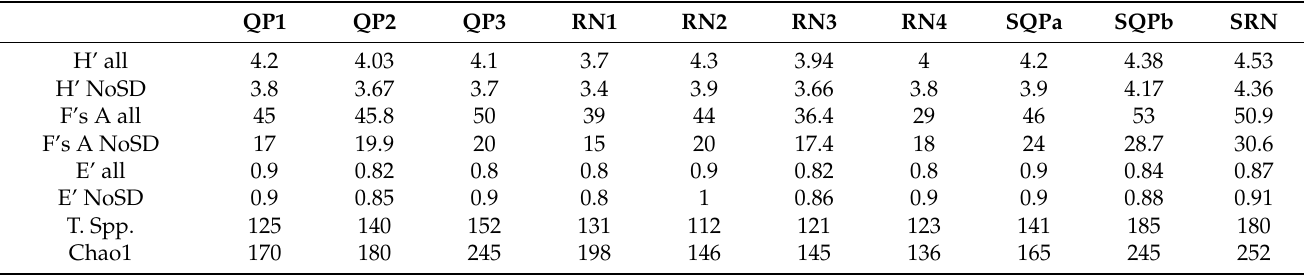
Table 5. Biodiversity indices values of each studied forest site (NNP, Podlaskie, North-East